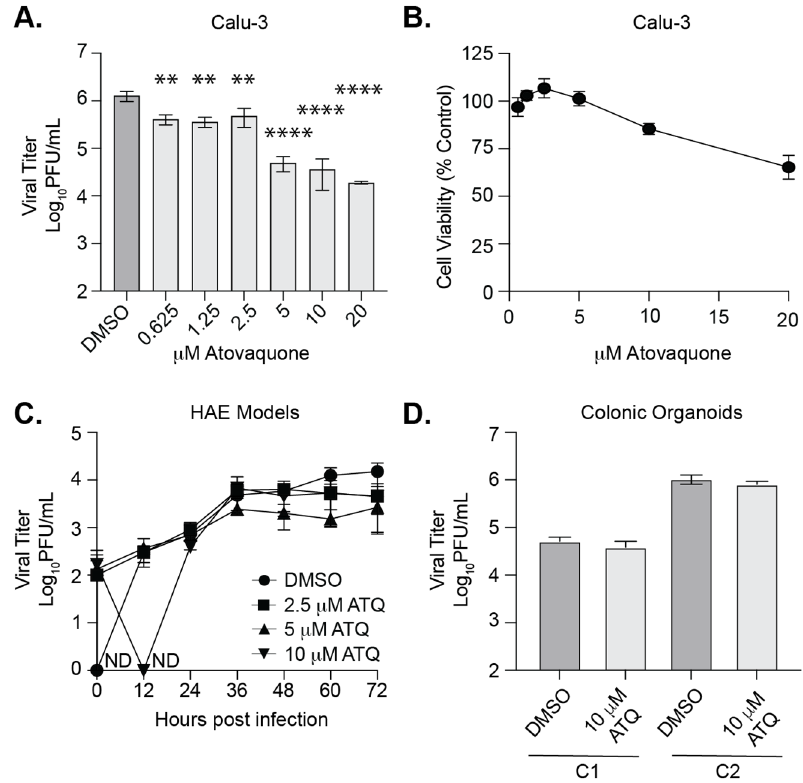
Figure 4. Effect of atovaquone in Calu-3 cells and human airway epithelial cultures and human colonic organoids. ( A ) Calu-3 cells were pretreated with increasing concentrations of ATQ for 2 h, infected with SARS-CoV-2-mNG at an MOI of 0.1, and the compound added back. Viral titers were quantified in the supernatant at 36 hpi by plaque assay. Data represent the mean and range of two independent experiments with internal duplicates. Two-way ANOVA. ** p < 0.01, **** p < 0.001. ( B ) Atovaquone cytotoxicity on Calu-3 cells by MTT assay. ( C ) Human airway epithelial cultures were pretreated with ATQ for 2 h, infected with icSARS-CoV-2-mNG, and the compound replaced. Viral titers were quantified in the culture supernatant by plaque assay. ( D ) Human colonic organoid cultures (C1 and C2) were pretreated with 10 μ M ATQ for 2 h, infected with SARS-CoV-2-mNG at MOI of 0.5, and cultured in the presence of compound for 36 h. Viral titers in the supernatant were quantified by plaque assay. ND = not detected (below limit of detection).